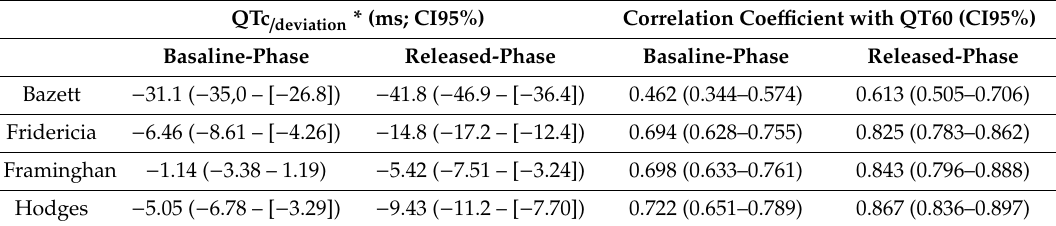
Table 4. QTc / deviation and the correlation coe ffi cients with the QT60.